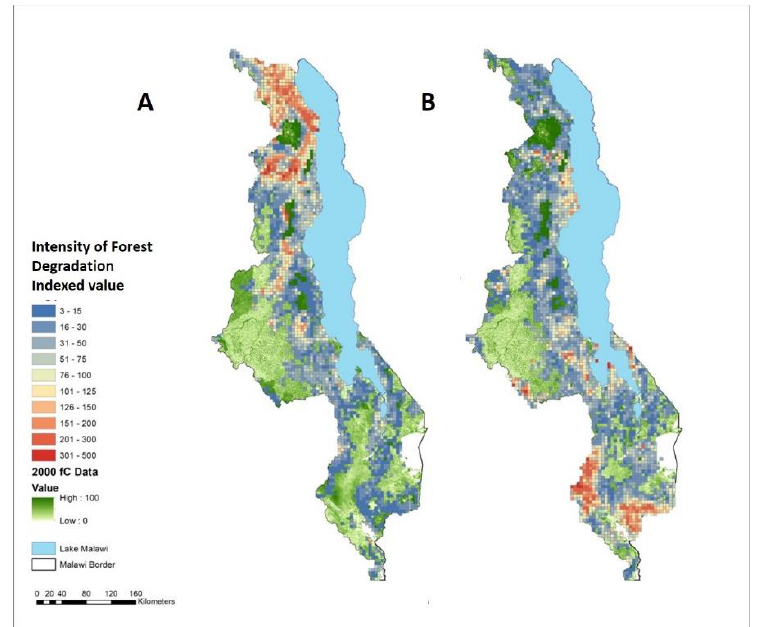
Figure 7. Mapping of degradation intensity, 2000–2009 ( A ) and 2010–2015 ( B ). These maps are used to display where degradadtion is most severe. Thus, two cells could have the same area of forest degradation but containg different intensities of degradation. To compute the intesity we